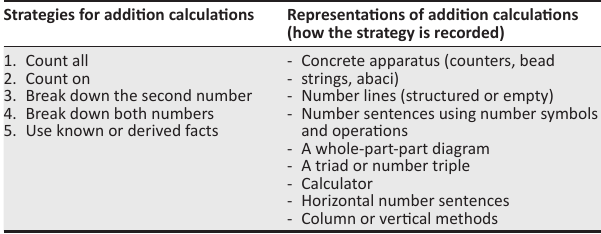
TABLE 2: Strategies and representation for addition in CAPS. Strategies for addition calculations Representations of addition calculations (how the strategy is recorded)